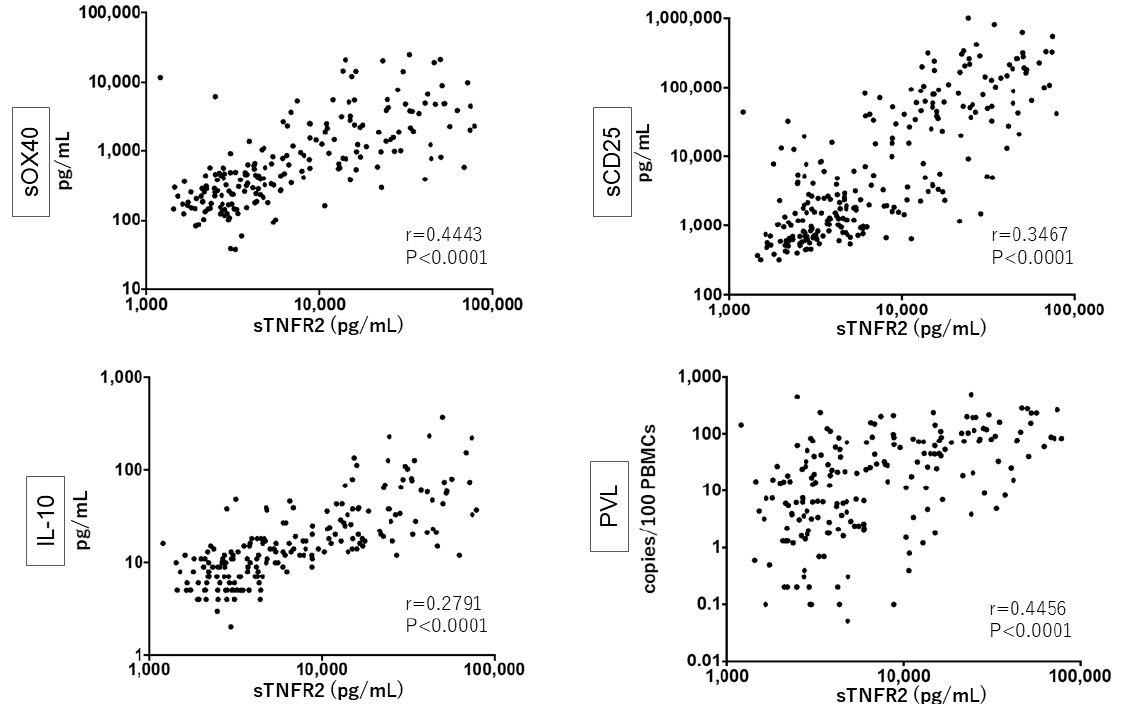
Figure 2. Correlation of plasma sTNFR2, sOX40, sCD25, and IL-10 levels and PVL in ATL patients and ACs. Samples tested were from 128 ATL patients and 110